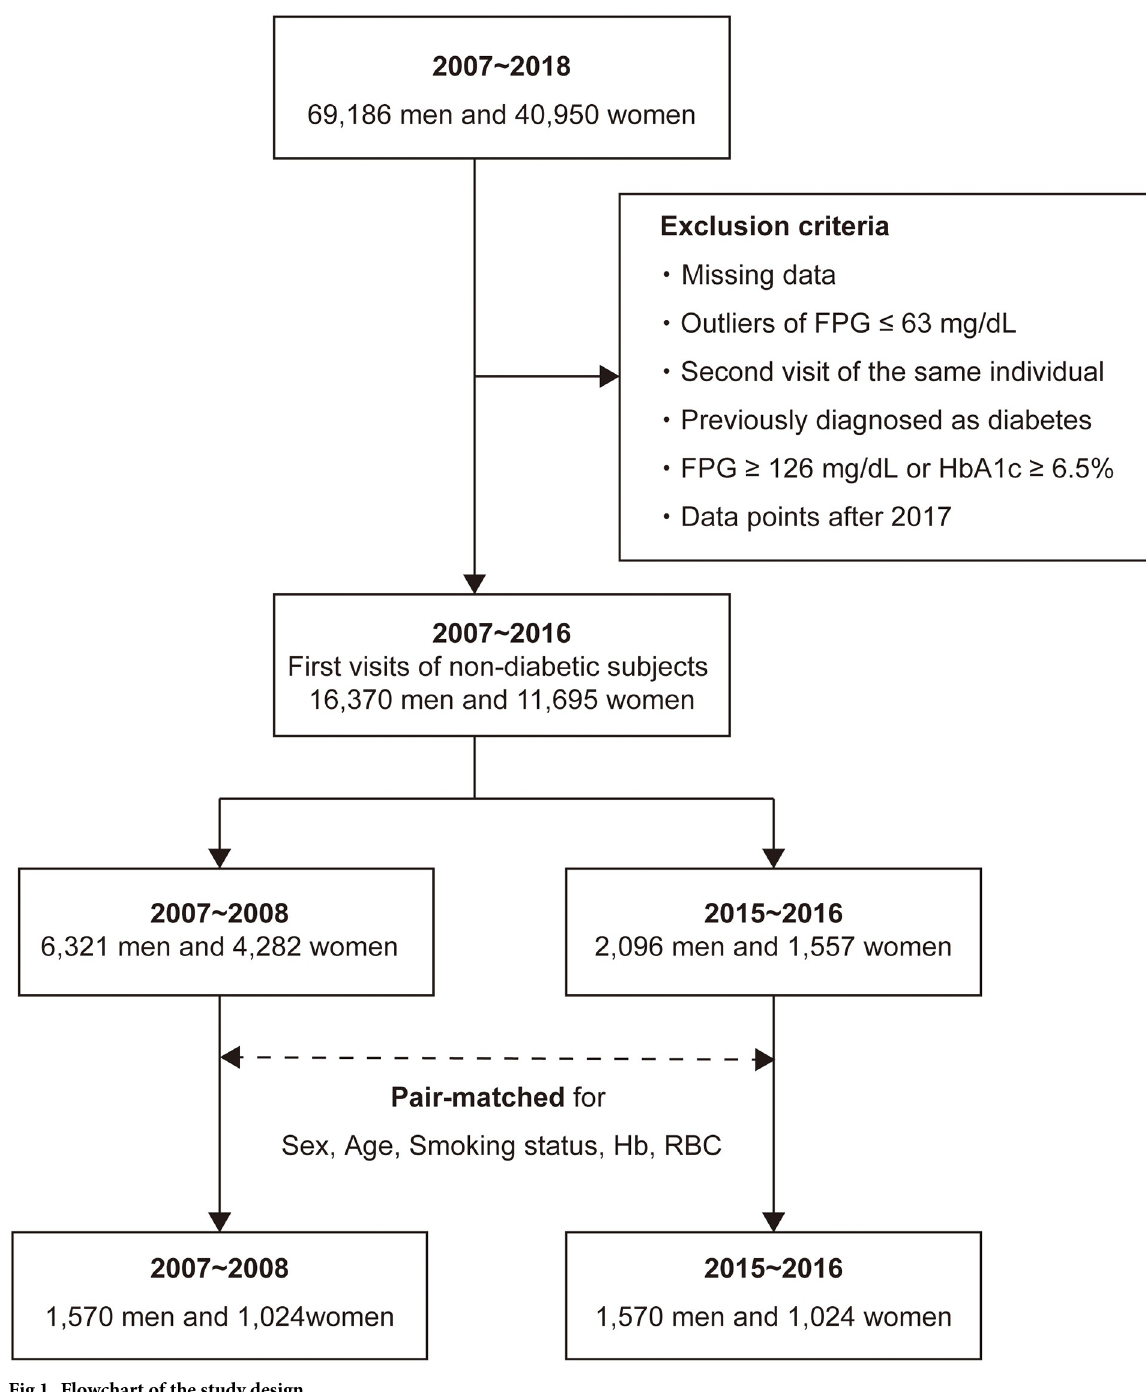
Fig 1. Flowchart of the study